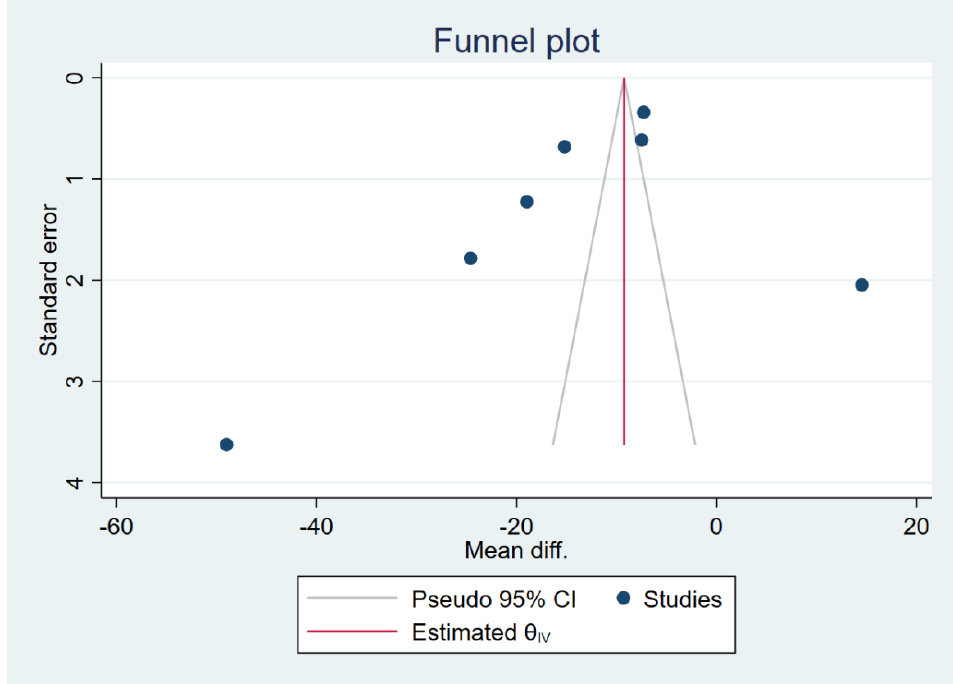
Figure 8. Funnel plot demonstrating the MD in TGF-β levels between uncomplicated malaria and healthy controls (pg/mL). The plot shows an asymmetrical distribution of the effect estimates (blue dots) from the middle line (red line). Abbreviations: Mean diff., MD; Estimated θ IV , overall effect size. The meta-analysis results of the difference in TGF- β levels between patients with